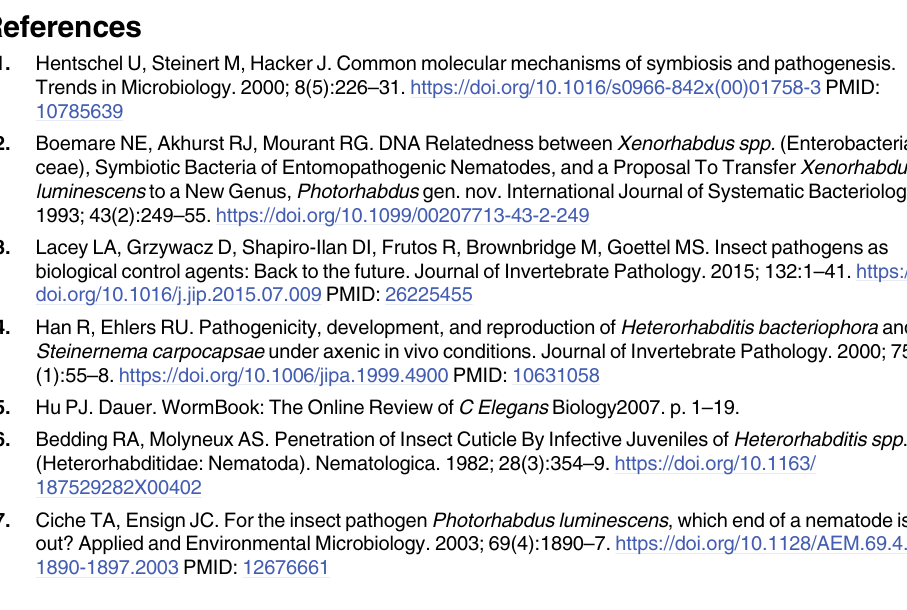
S1 Table. Primers used in this study. S2 Table. Phenotypes of P . luminescens TT01 Chr_ dam and Chr_ gfp strains.